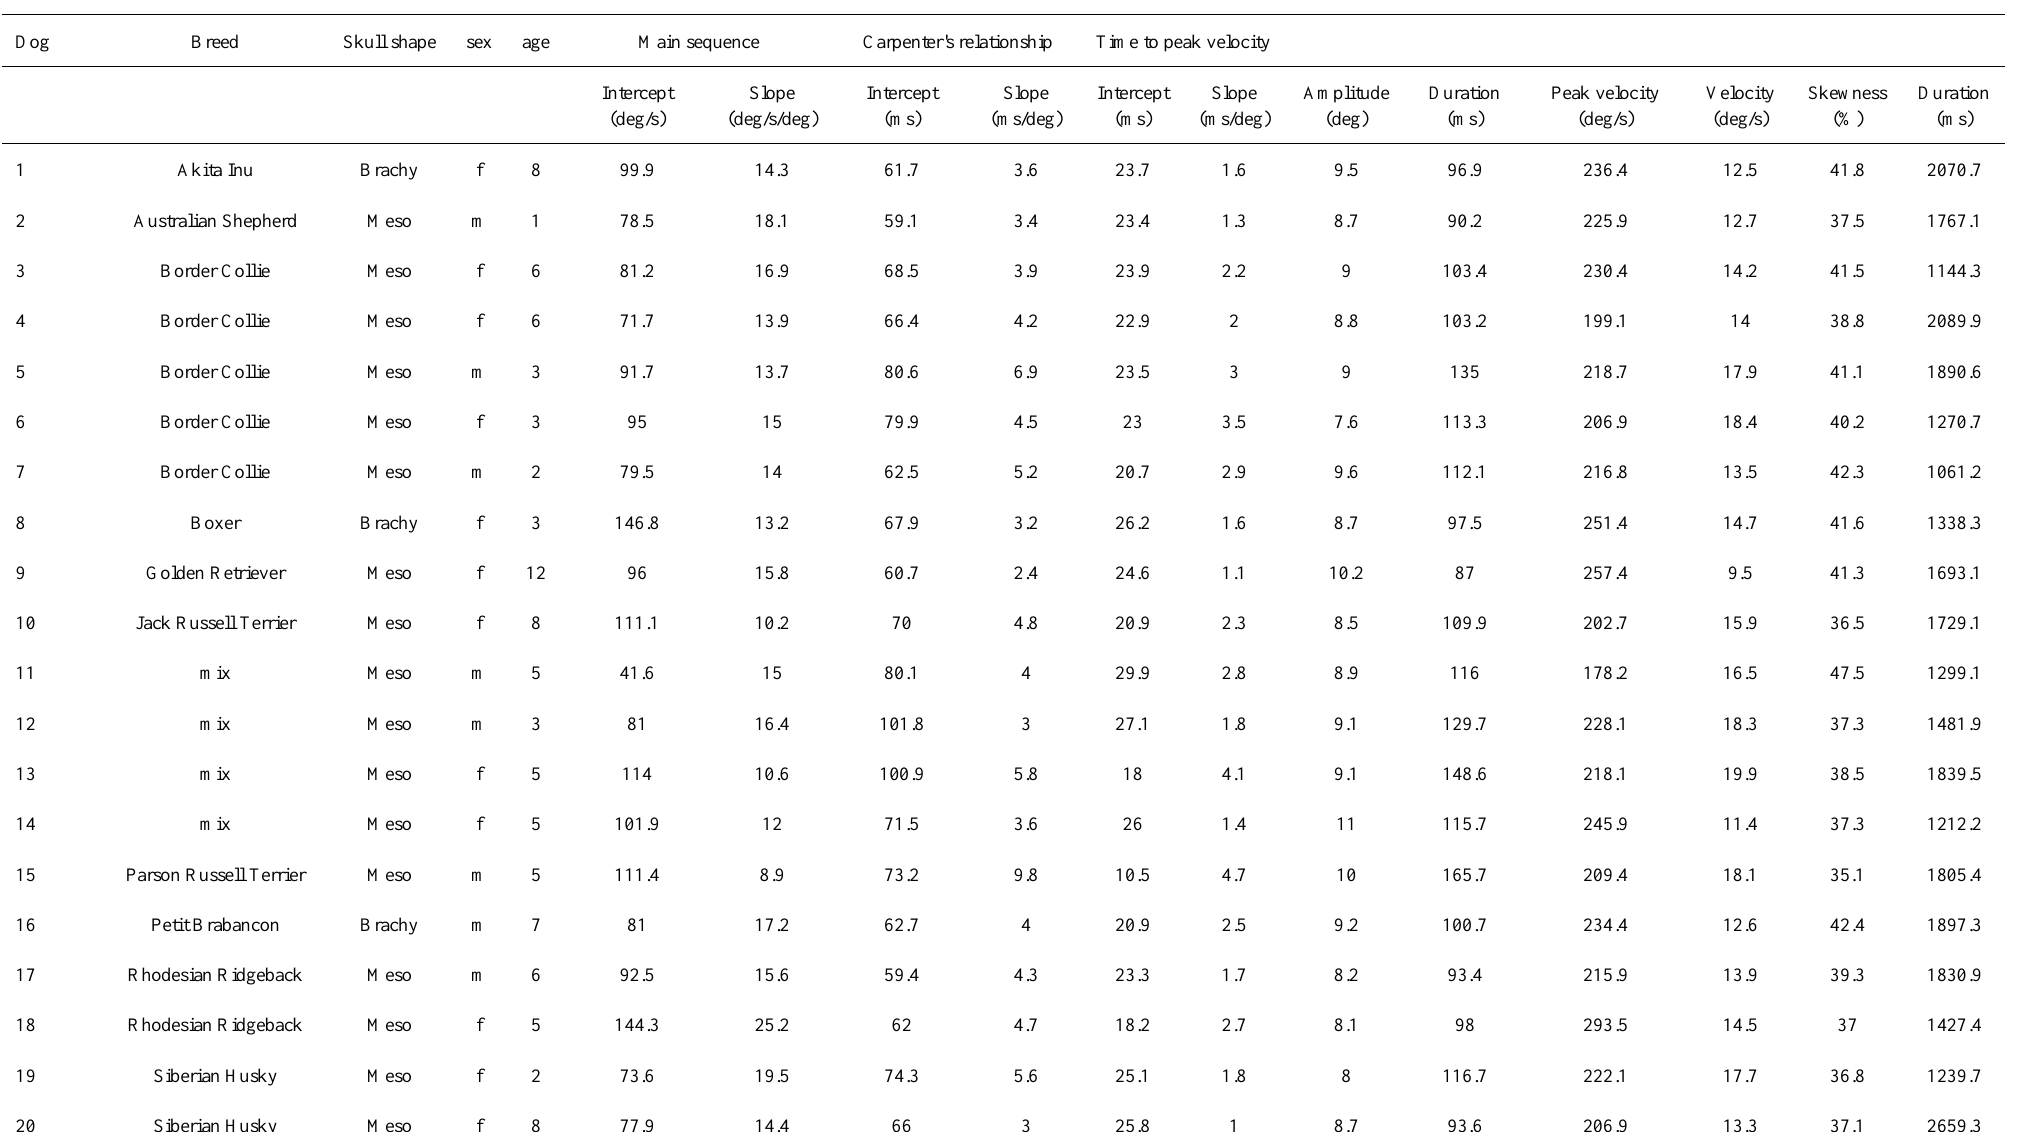
Table 5 Summary table of the dog saccade and fixation statistics in the